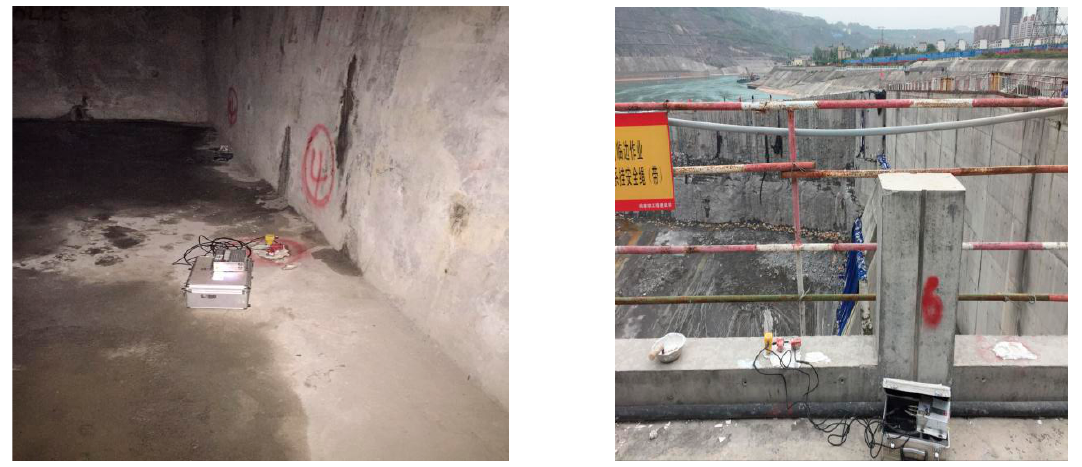
Figure 6. Layout of blast-induced vibration monitoring points.